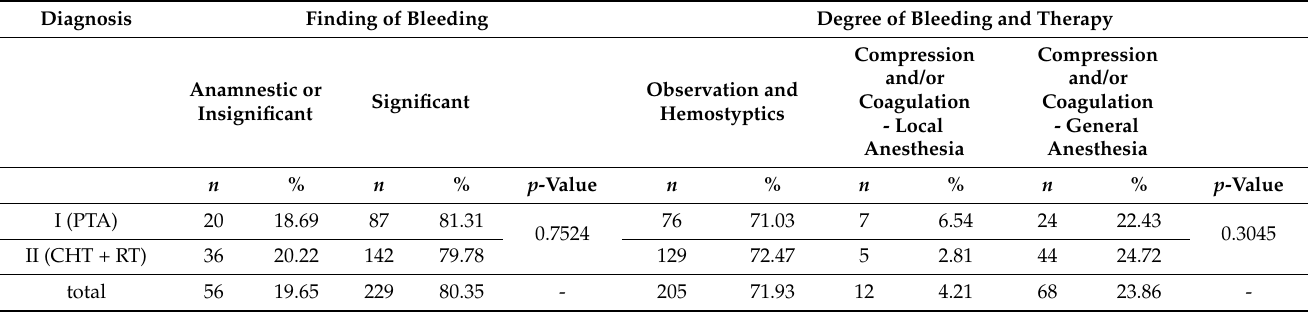
Table 5. Finding at the time of examination and degree and management of